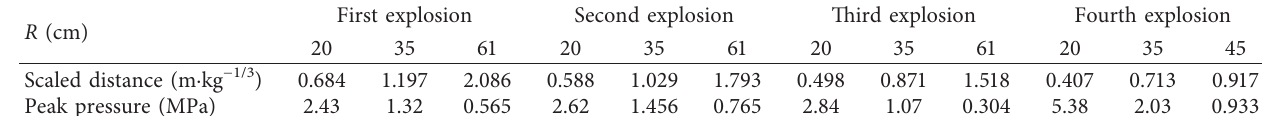
Table 4: Scaled distances and peak pressures of measuring points.